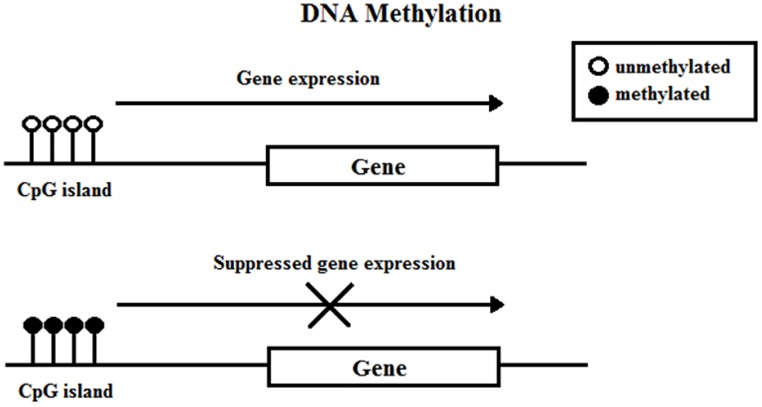
DNA methylation.